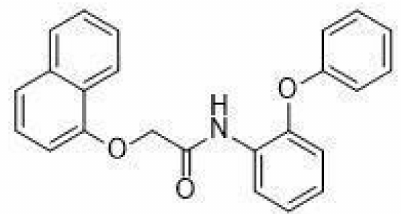
Figure 1. Structure of GRA2,